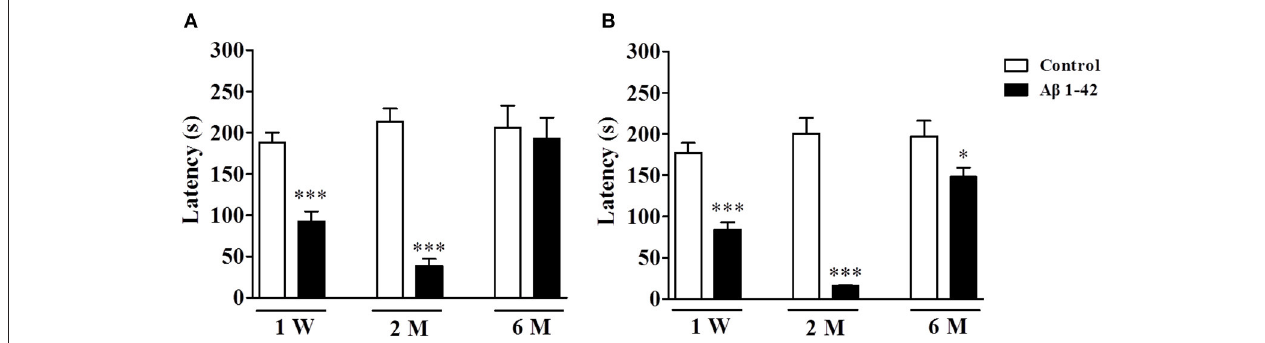
FIGURE 2 | A β 1-42 induced memory impairment in the step-down passive avoidance test at 1 week, 2 and 6 months after intracerebroventricular microinjection of A β 1-42. Retention tests were conducted 3 (A) and 24h (B) after the training session. Values shown are means ± SEM, n = 10; * p < 0.05 and *** p < 0.001 vs. vehicle-treated control group.